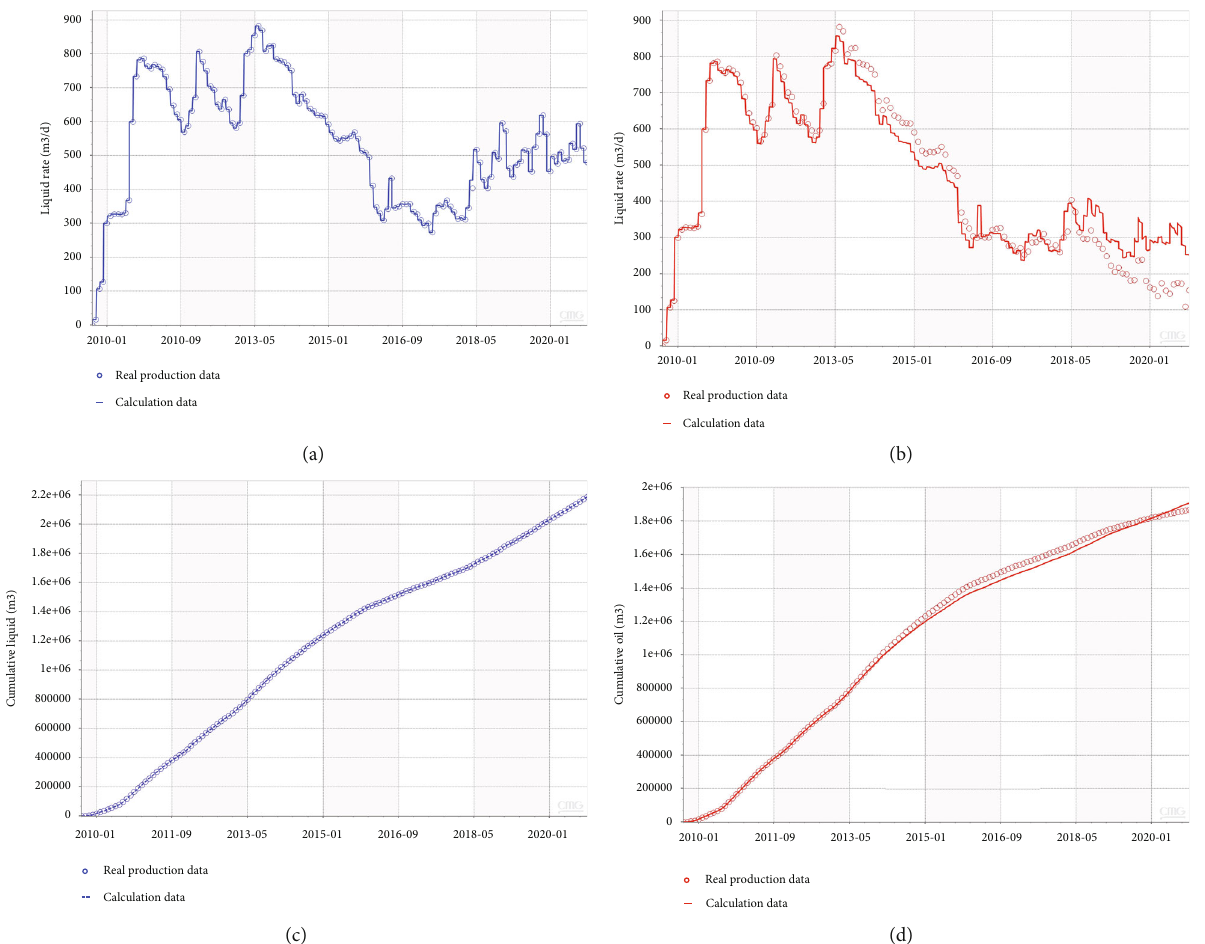
Figure 4: Fluid production and oil production fi tting curves of the L11